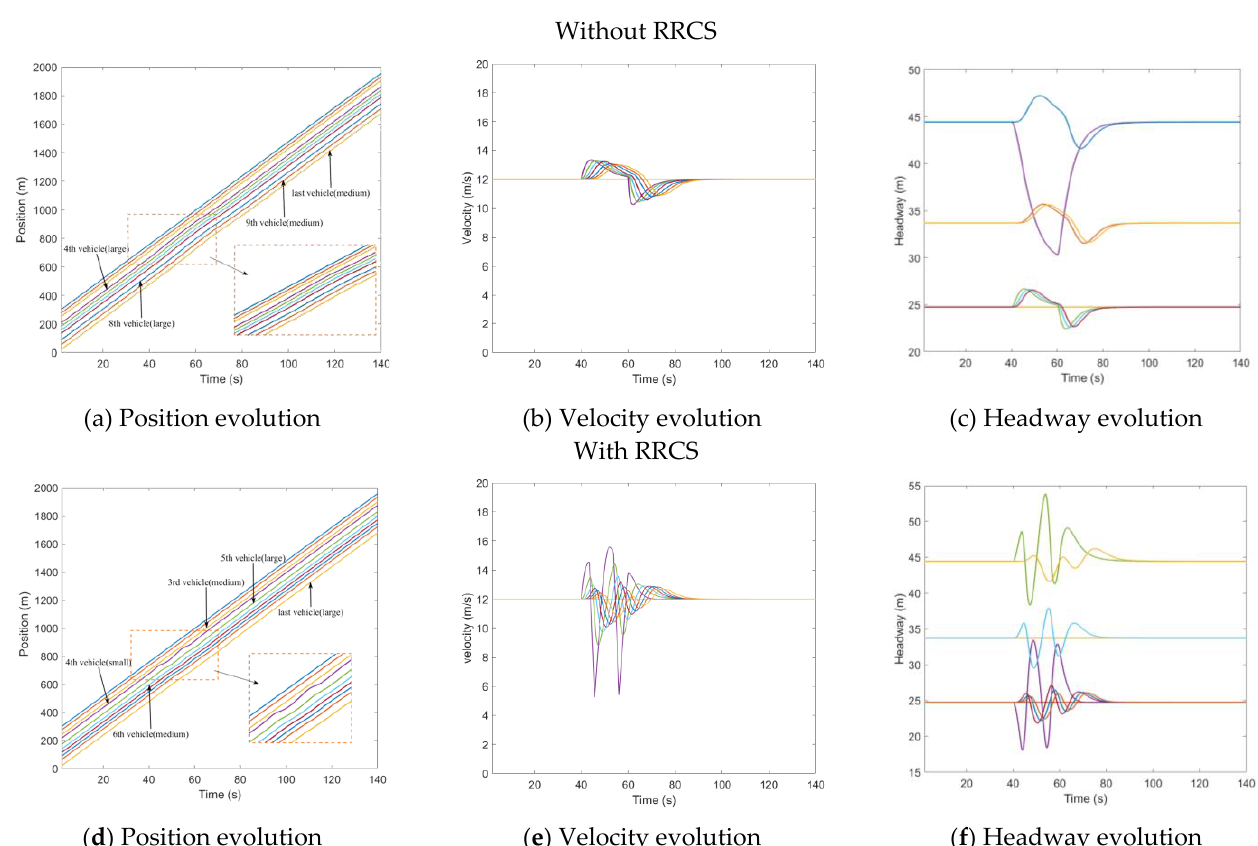
Figure 5. Mixed traffic flow evolution diagrams under the overestimated position with/without RRCS. Underestimate